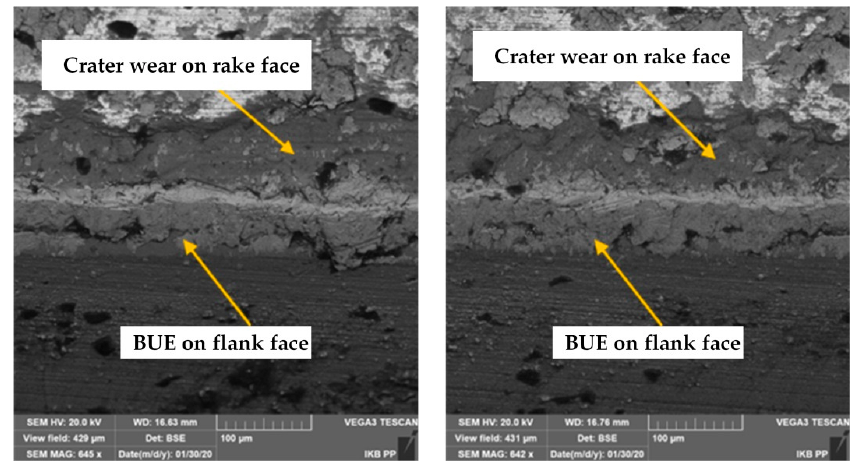
Figure 8. The SEM images of DDCC inserts after grooving with v c = 1200 m/min, f = 0.2 mm/rev, t s ≤ 2 min.